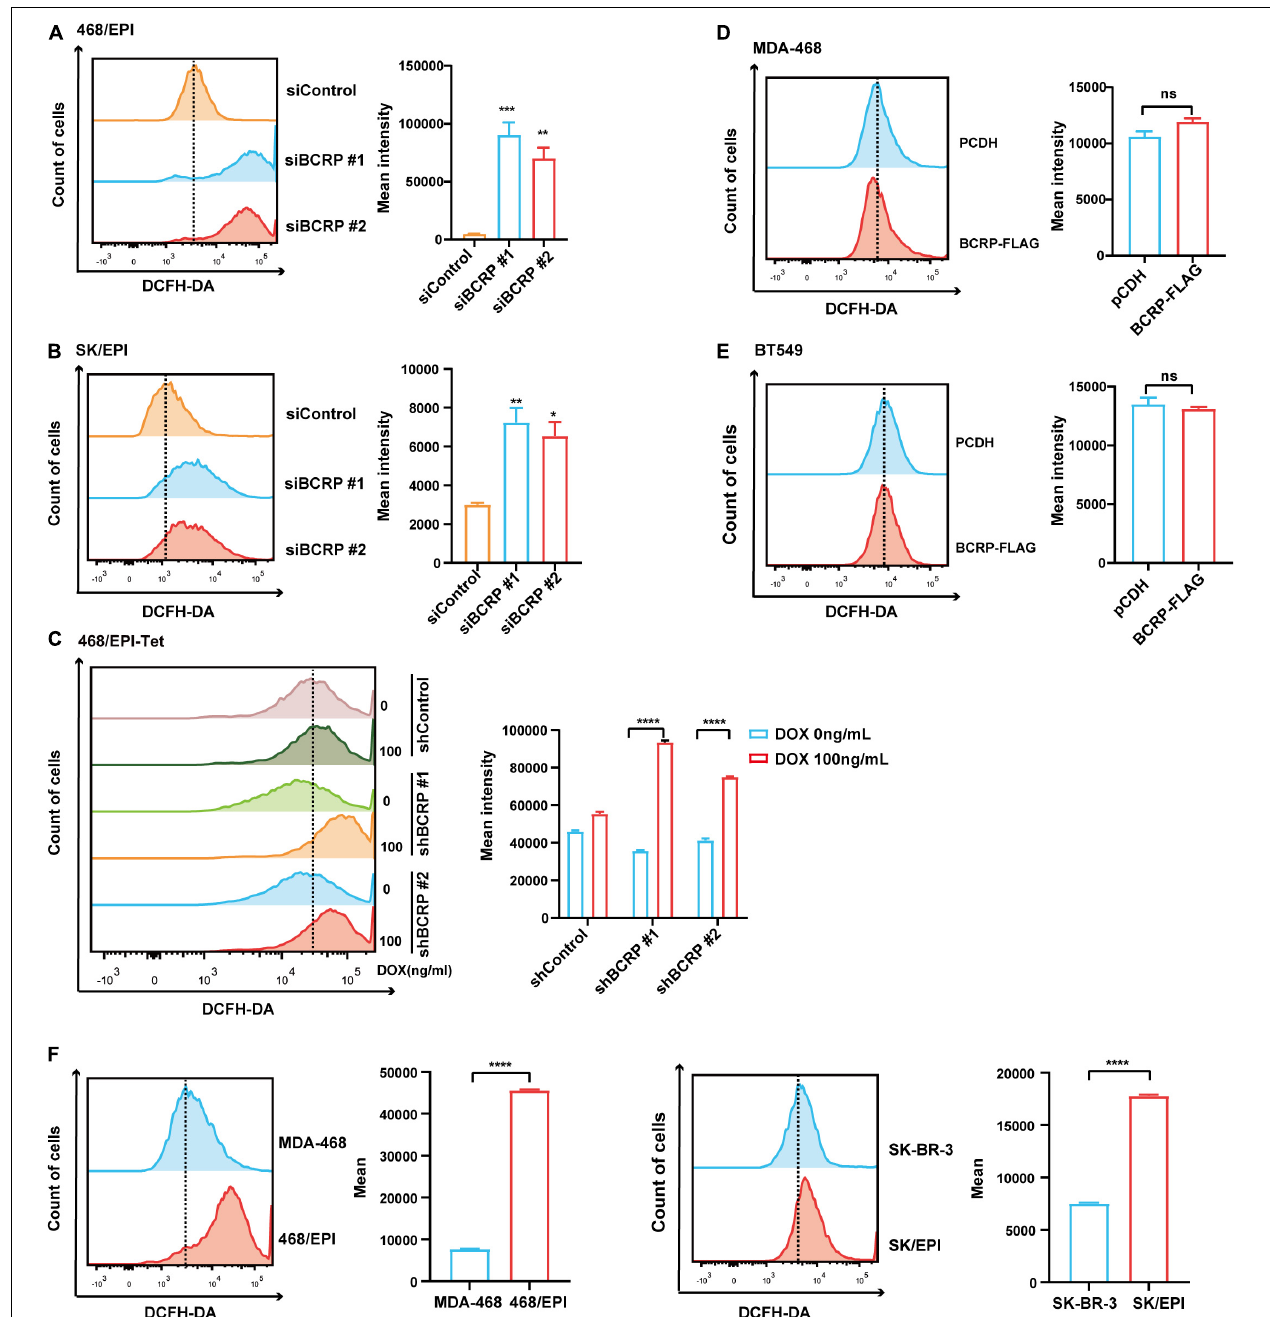
FIGURE 6 | BCRP inhibits ROS production in drug-resistant breast cancer cells. (A,B) Analysis of intracellular ROS level in 468/EPI cells (A) and SK/EPI cells (B) treated with siBCRP or control siRNAs. The cells were treated with the indicated siRNAs for 48 h, and then, the ROS level was determined. (C,D) Analysis of intracellular ROS level in MDA-468 cells (C) and BT549 cells (D) with or without BCRP overexpression. (E) Analysis of intracellular ROS level in 468/EPI-tet or control cells with or without Dox treatment. The cells were treated with the Dox for 48 h, and then, the ROS level was determined. (F) Analysis of intracellular ROS level in drug-resistant cells (468/EPI and SK/EPI) and the matched parental cells (MDA-468 and SK-BR-3). All data are shown as the mean ± SD; * p < 0.05. ** p < 0.01, *** p < 0.001, **** p < 0.0001, and ns p > 0.05 versus control, N =